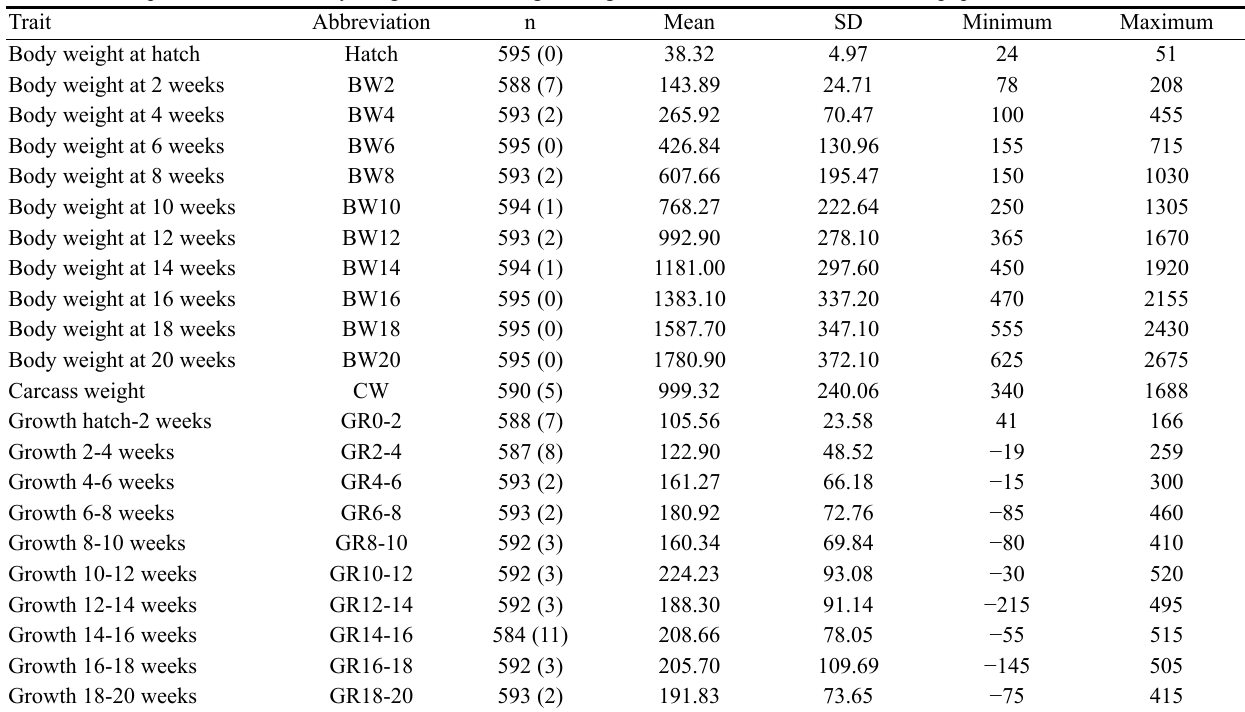
Table 1. Descriptive statistics of body weight, carcass weight and growth in the Korean native chicken population